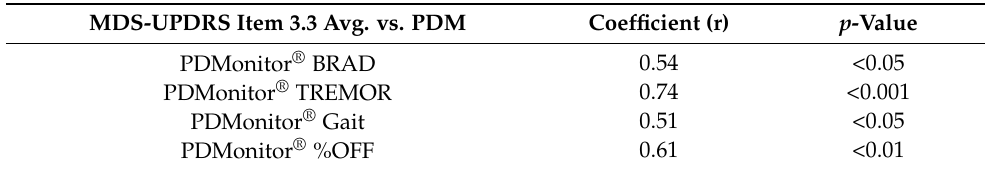
Table 4. The correlation of the MDS-UPDRS rigidity score (total average) to the PDMonitor ® average values on bradykinesia, tremor, gait, and %OFF using Pearson’s coefficient.